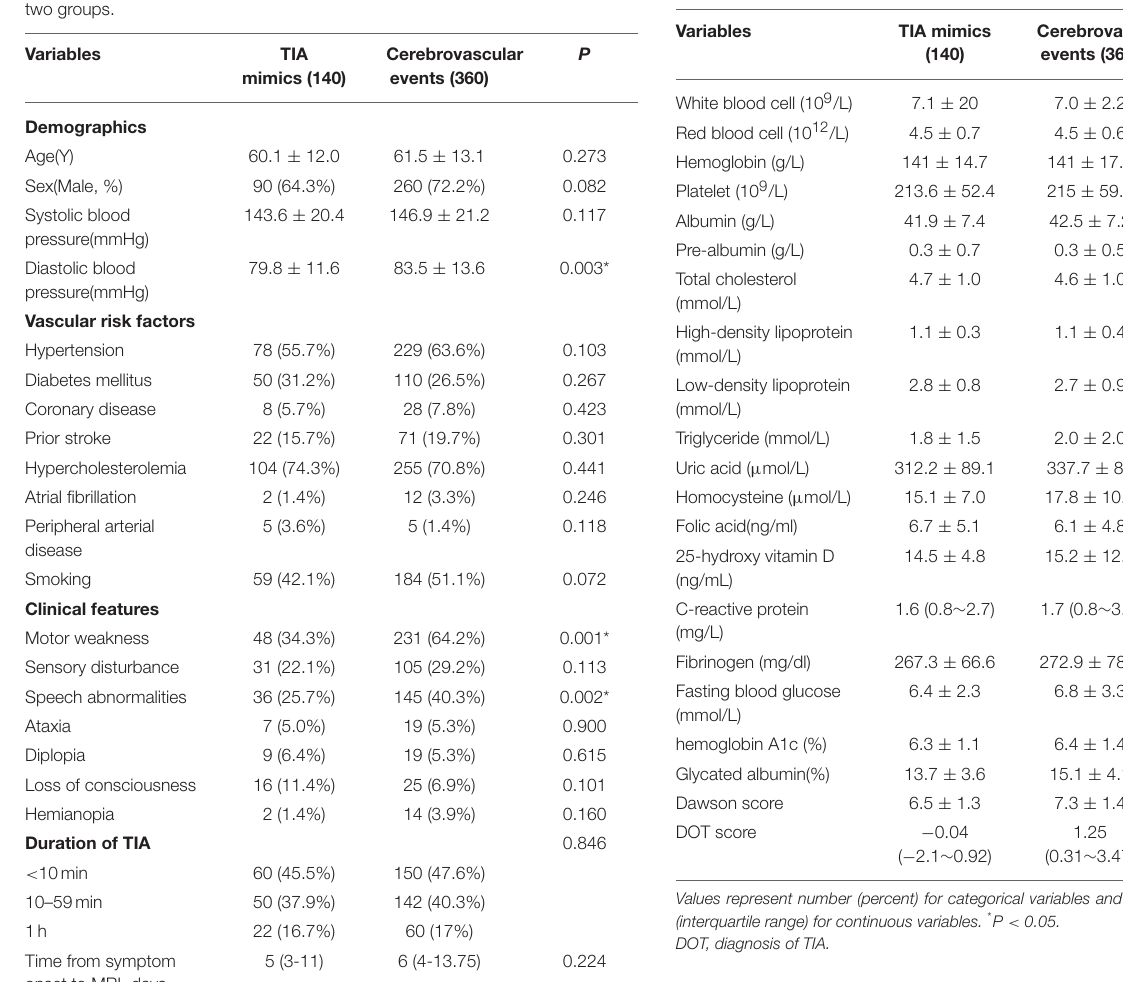
TABLE 3 | The baseline demographics, clinical characteristics between the two groups.